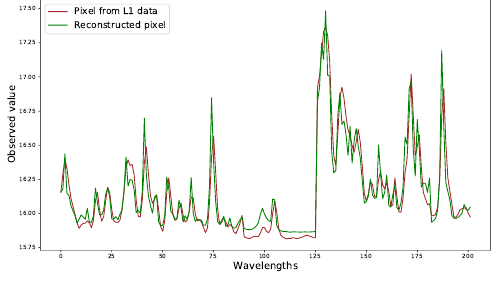
Figure 5. Comparison between the original pixel and the approximated pixel when using a wavelength mask.